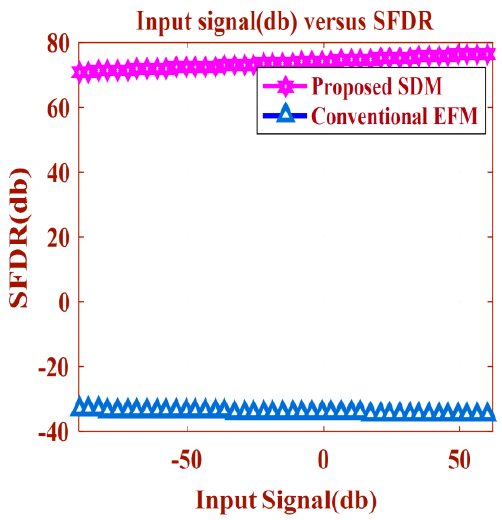
Figure 16. SFDR vs. Input signal.